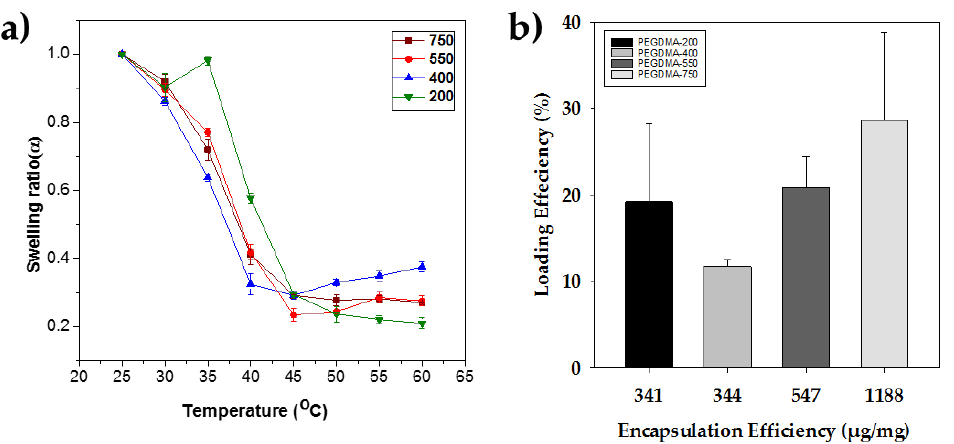
Figure 5. ( a ) Swelling ratios of nanogels as a function of temperature. ( b ) Encapsulation efficiency as a function of loading efficiency for nanogels.